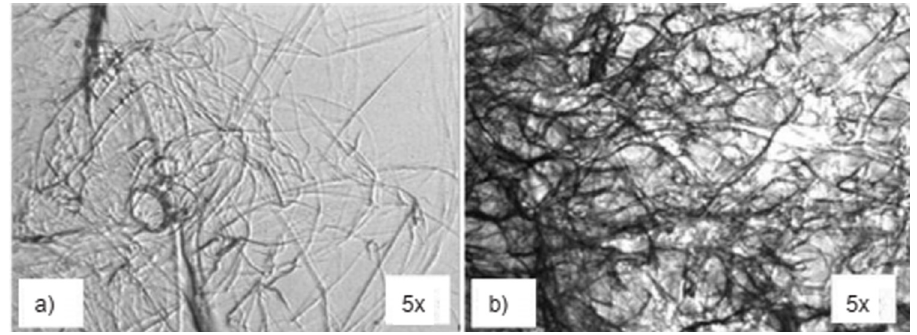
Figure 7: Microscopic images of chitin fi bers ( powder of chitin extracted from shrimp shells ( Pandalus borealis )) in 1 - butyl - 3 - methylimi - dazolium acetate BMIM OAc, produced by the solution blow spinning method ( a and b ) mag: 5 × , fi ber diameter: 0.3 – 30 µm; ( b ) mag: 5 × , fi ber diameter: 0.3 – 30 µm. Image reprinted with permission from [ 92 ] Ł ukasiewicz Research Network - Institute of Biopolymers and Chemical Fibres, in accordance with the BOAI.